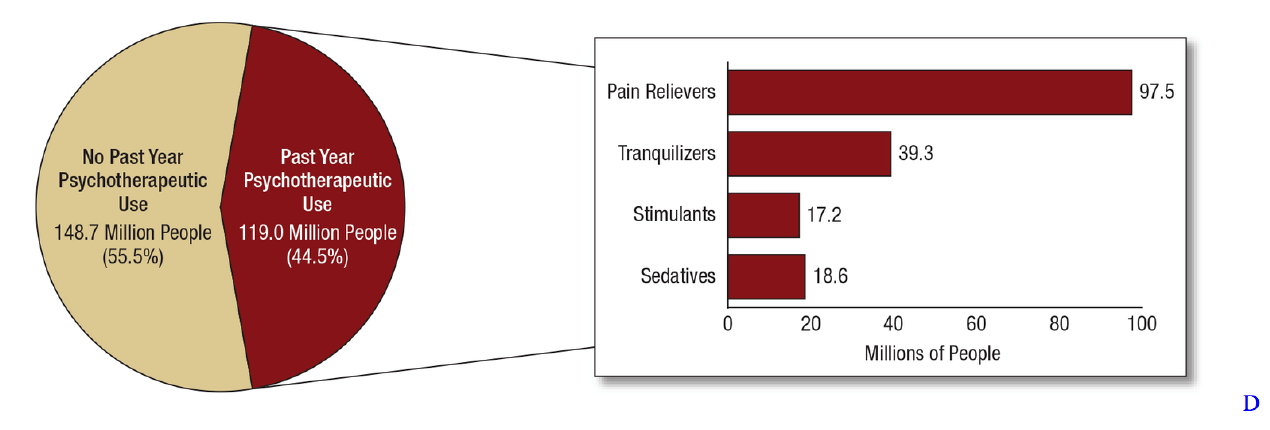
Figure 1. Numbers of past year prescription psychotherapeutic users among people aged 12 or older: 2015 31 . NSDUH, National Survey on Drug Use and